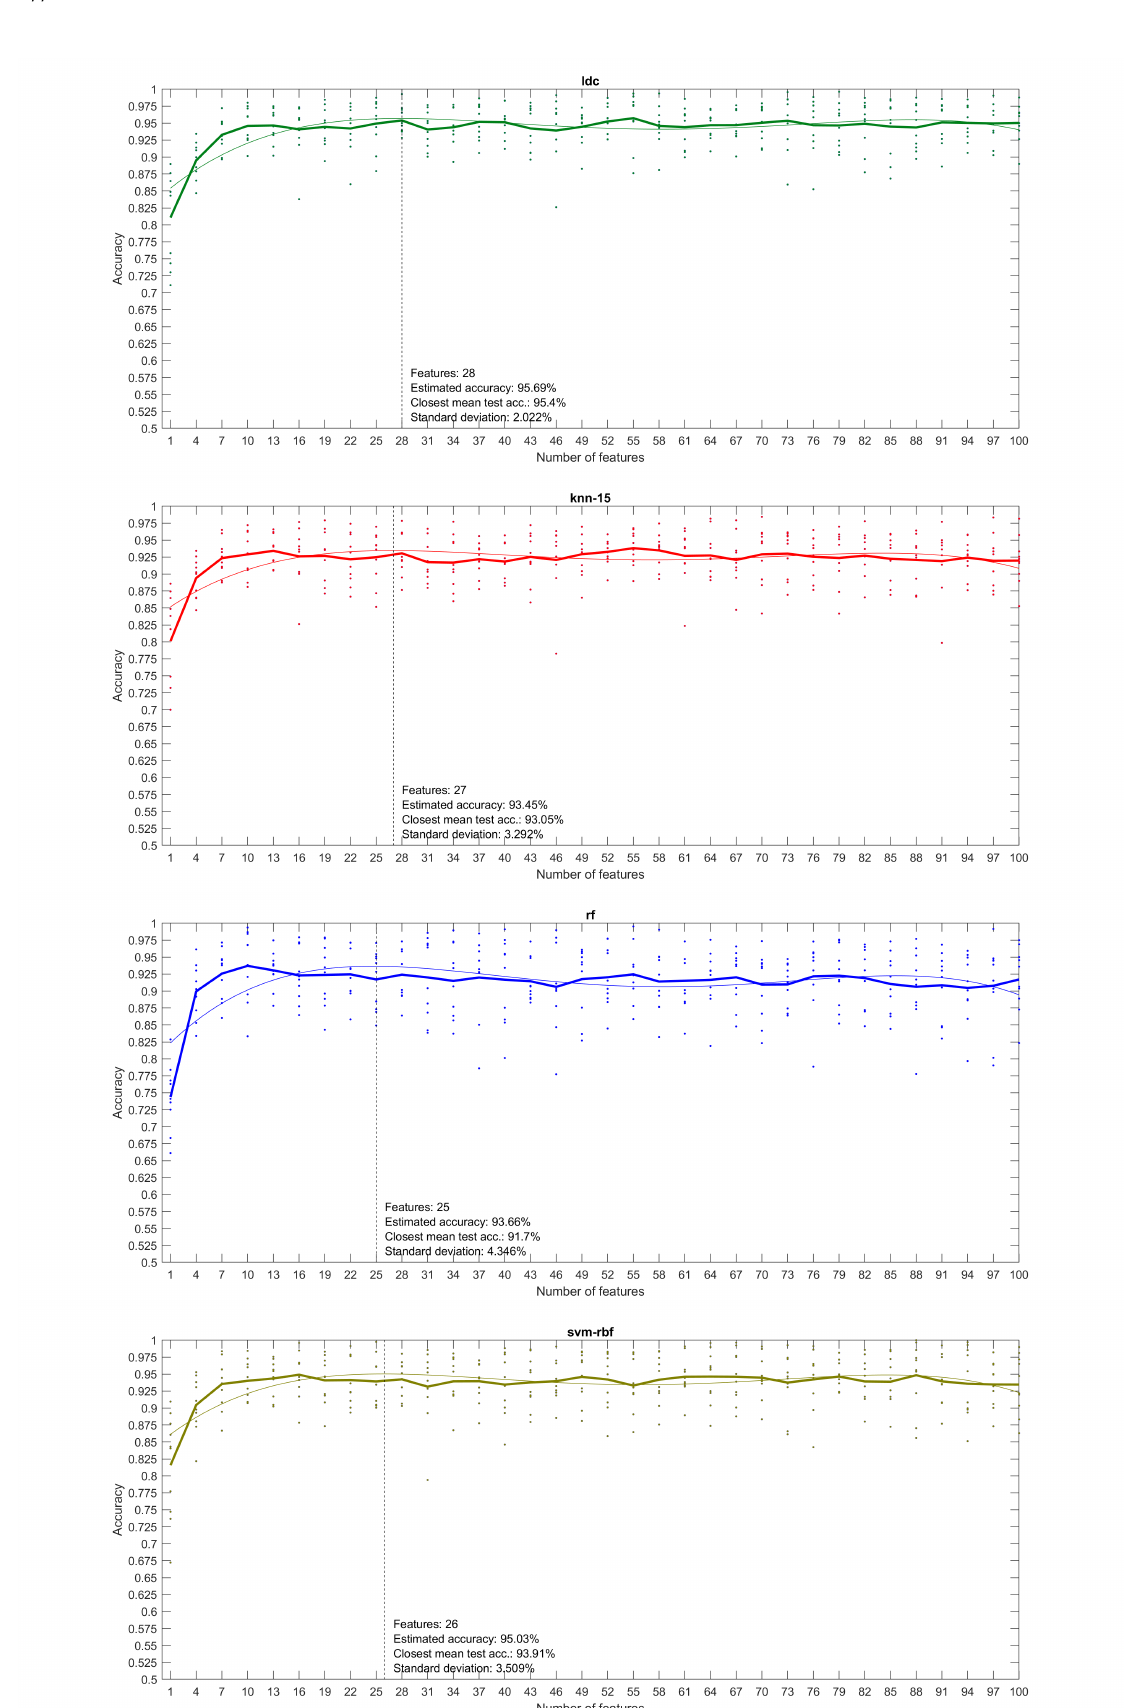
Figure 13. SRD cross validation training results per feature subset and fitted curve used to select the best